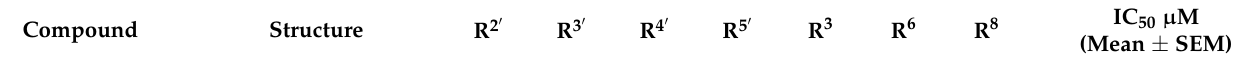
Table 2. Structures of the studied flavonoids and AgNP (4 and 19 nm)-induced inhibition in human neutrophils, assessed by DHR (IC 50 µM, mean ± SEM).